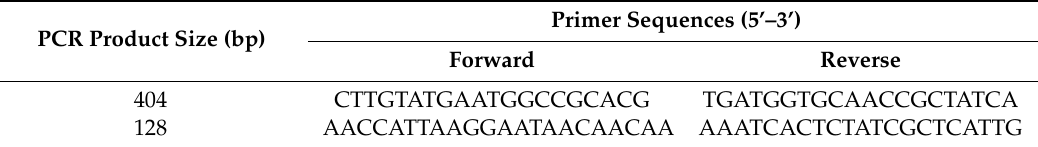
Table 1. Primers designed in this